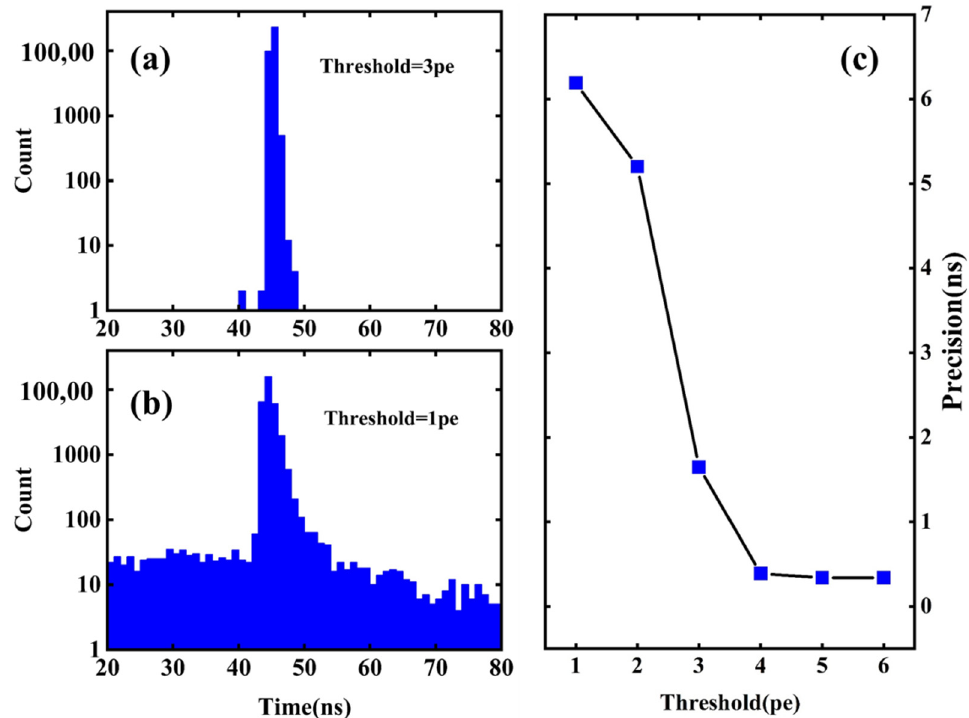
Figure 6. ( a , b ) Triggered time tag distribution of 3 p.e. and 1 p.e. detection threshold. ( c ) Relationship between system precision and threshold.